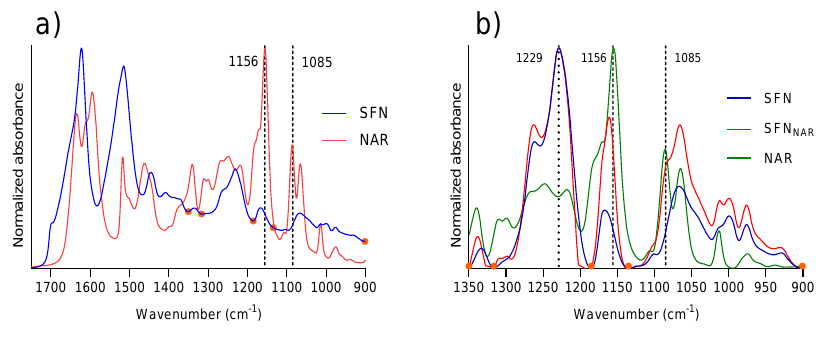
Figure 2. ( a ) Original infrared absorption spectra of SFN and NAR. ( b ) Base-line corrected infrared absorption spectra of SFN, NAR and SFN NAR -1.2. The SFN and the SFN NAR spectra are normalized to an absorbance of 1 at the maximum of the amide III band at 1229 cm − 1. The NAR spectrum is normalized to an absorbance of 1 at 1156 cm − 1 . All samples were measured as a dry film obtained from a 30% EtOH solution. Orange dots indicate the baseline points.